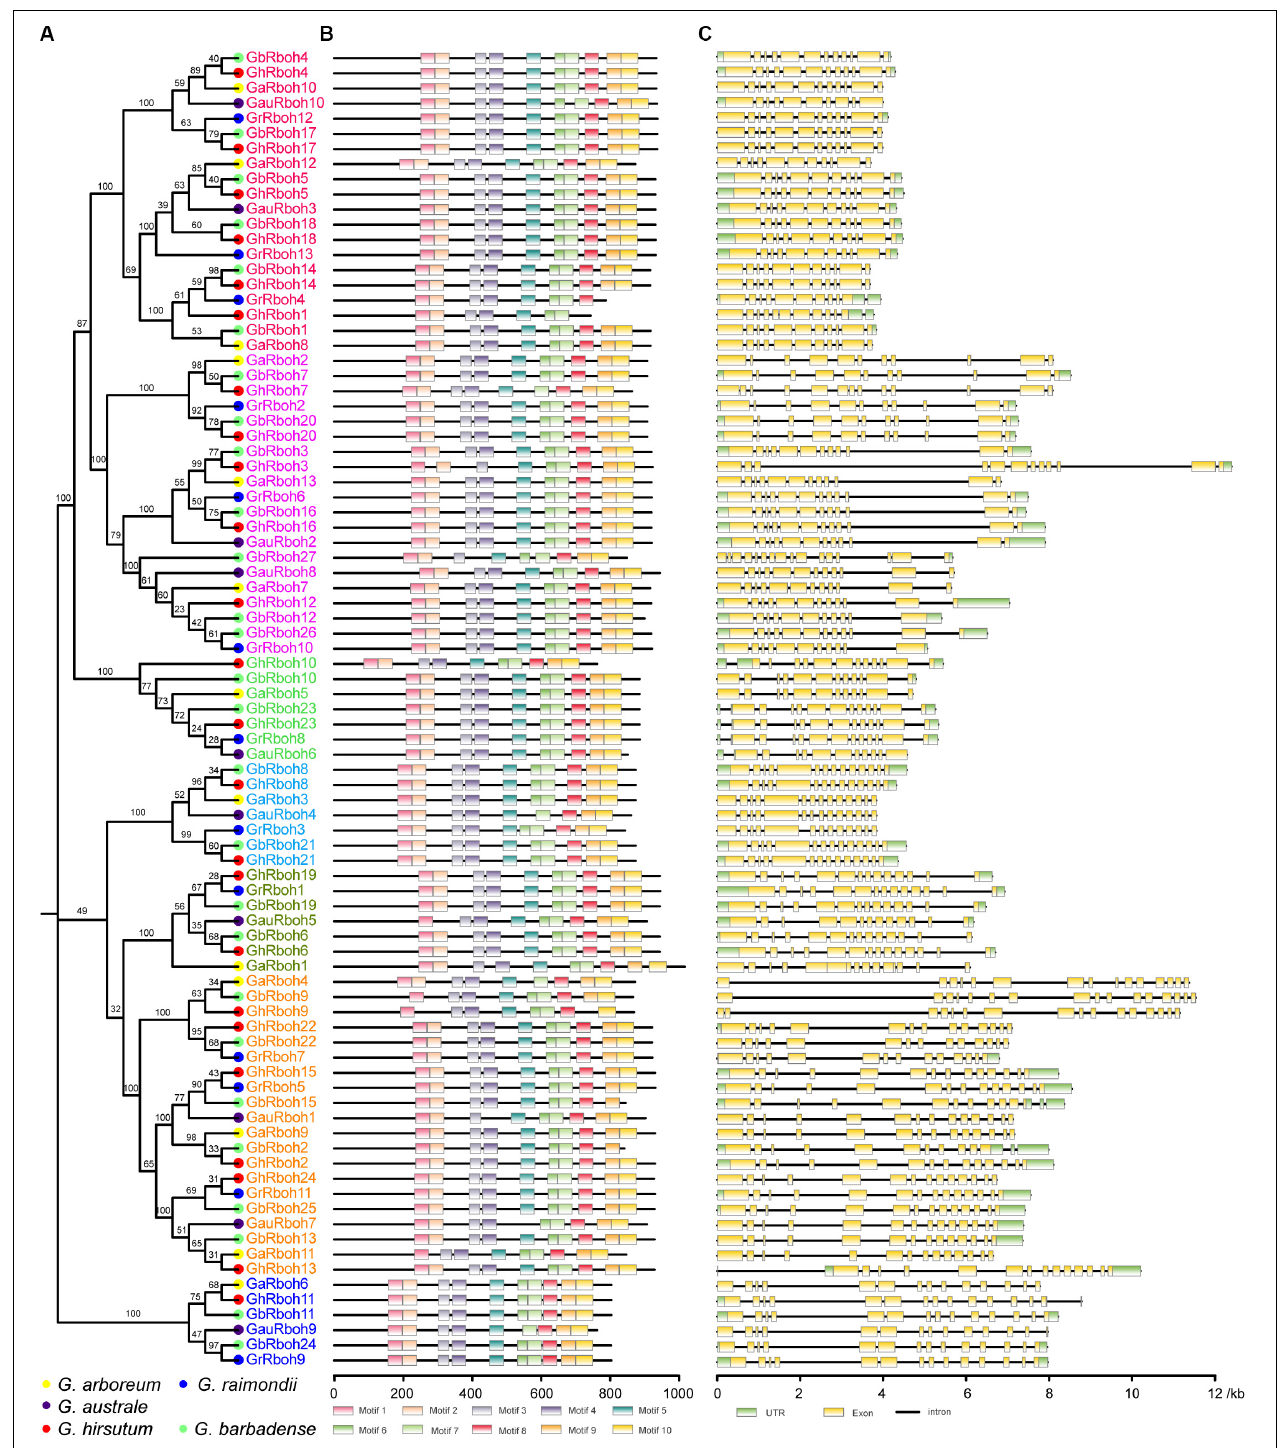
FIGURE 2 | Characterization of the 87 Rbohs in five Gossypium species. The characteristics include the homologous relationship, conserved domain location, and exon-intron structure. (A) Phylogenetic relationships among the Rbohs in five Gossypium species. Rbohs in same clade are indicated by the same color. Different-colored solid circles indicate genes in different Gossypium species. (B) Conserved domain architecture of cotton Rboh proteins. Motifs were identified through a MEME analysis (http://meme-suite.org/) and protein length was estimated via the scale at the bottom. (C) Exon-intron organization analyses of cotton Rboh genes. The gene length was estimated by the scale at the bottom through gene structure analyses (GSDS: http://gsds.cbi.pku.edu.cn/). Green boxes indicate 5 (cid:48) - or 3 (cid:48) -untranslated regions. Exons and introns are distinguished in yellow boxes and in black lines, respectively.